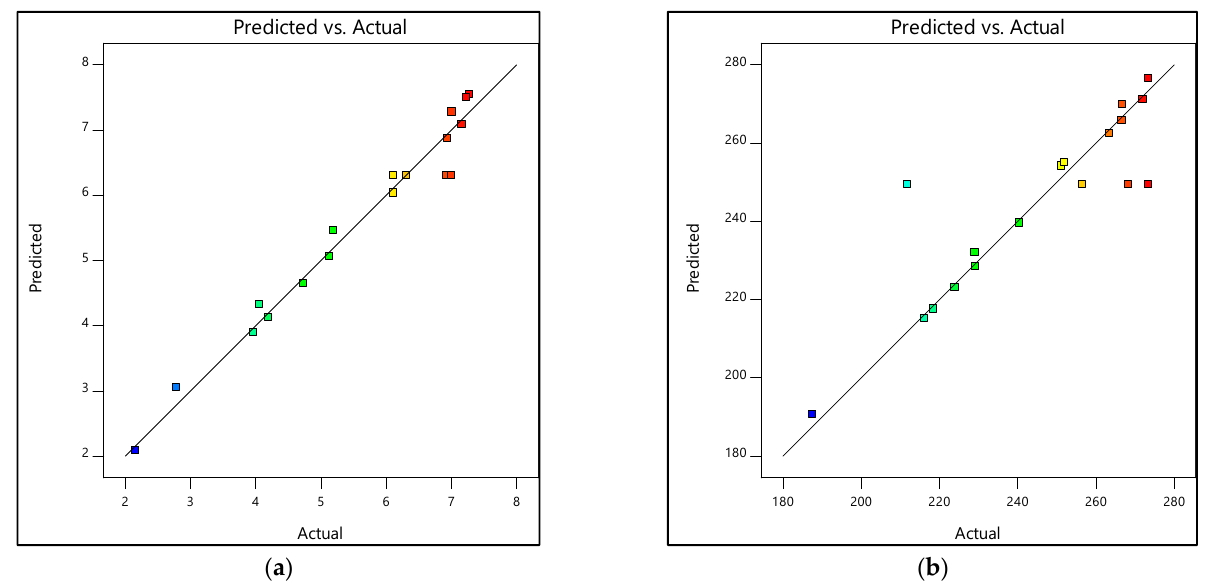
Figure 10. Prediction versus actual graphs for experimental designs of 20% and 80% water: ( a ) Tensile strength, ( b ) Young’s modulus.